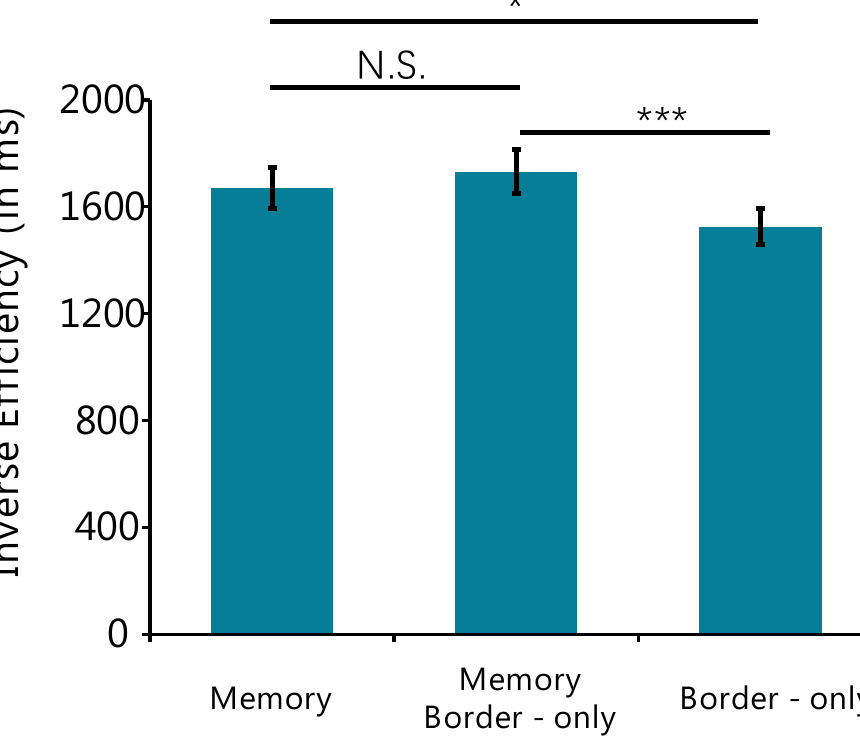
Figure 4. Inverse efficiency for the three conditions. Error bars are SEM. * indicates p < 0.05; *** indicates p < 0.001 ; N.S. indicates p > 0.1.